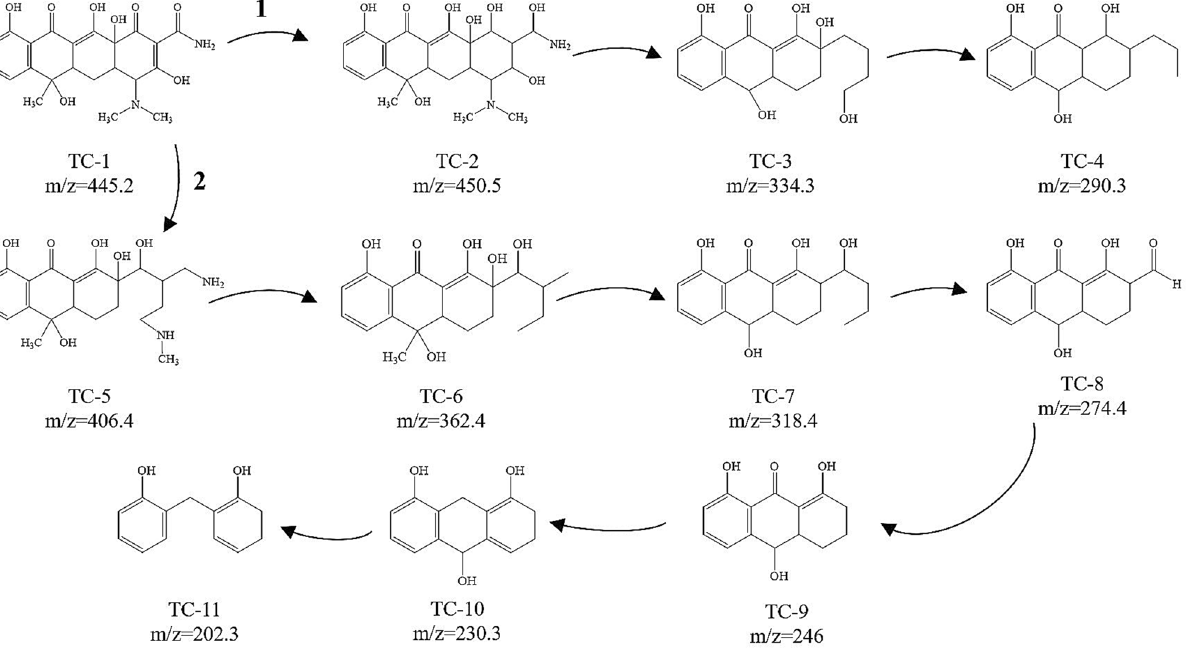
Scheme 1. Schematic diagram of proposed TC photodegradation pathway by ACA-2.